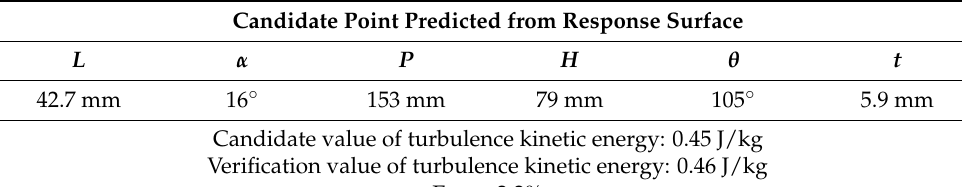
Figure 21. Verification of candidate point recommended from response surface after resetting for